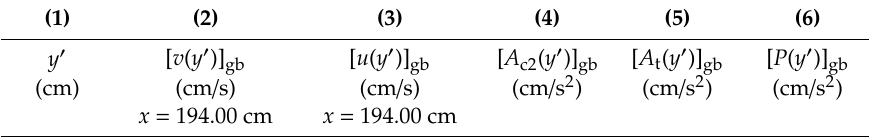
Table A3. List of velocity data for t = 2.069 s and calculation of second convective acceleration [ A c2 ( y (cid:48) )] gb , [ A t ( y (cid:48) )] gb and [ P ( y (cid:48) )] gb ( = [(1 / ρ ) ∂ p ( y (cid:48) ) / ∂ x ] gb ). Note that partially depth-averaged values